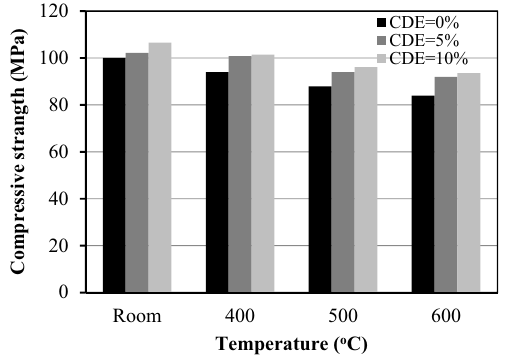
Figure 17: Mass loss of UHPC after being exposed to high temperatures.